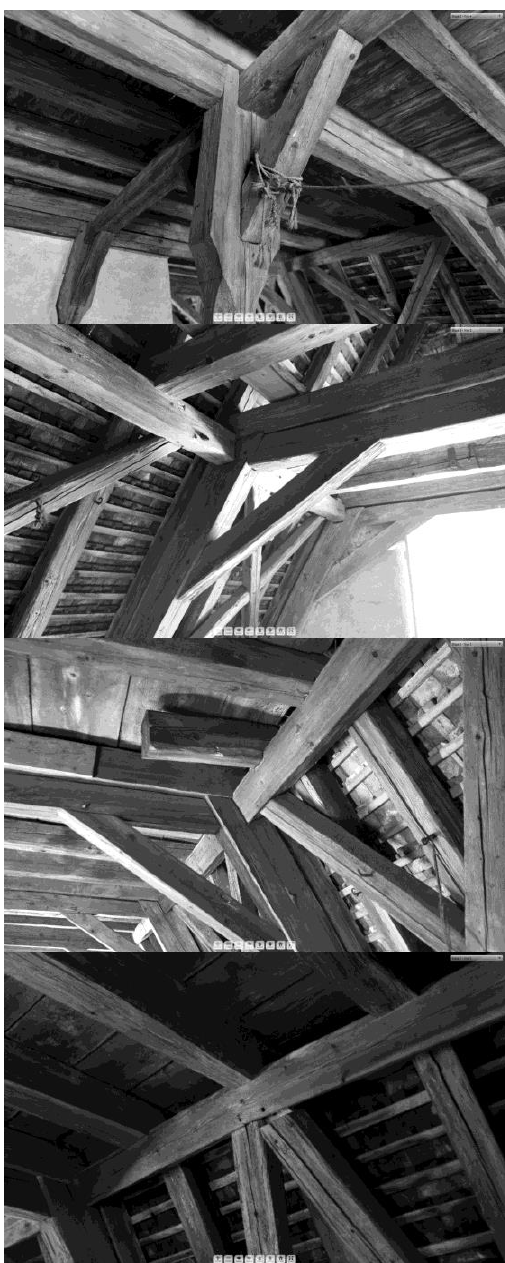
Figure 1.a, b, c: Framework assemblies, d: Assembly deformation